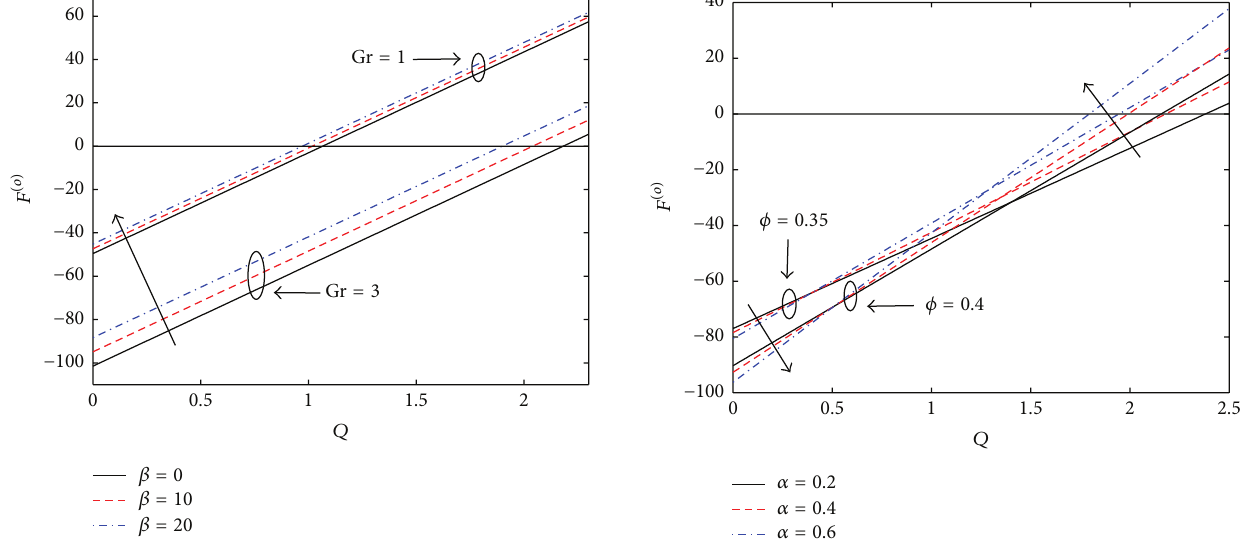
Figure 13: Frictional force on the outer tube 𝐹 (𝑜) versus the time- averaged flow rate 𝑄 for different values of the parameter 𝛼 1 and amplitude ratio 𝜙 with Gr = 3 , 𝜀 = 0.35 , 𝛽 = 10 , 𝜆 1 = 1 , and 𝑡 = 1